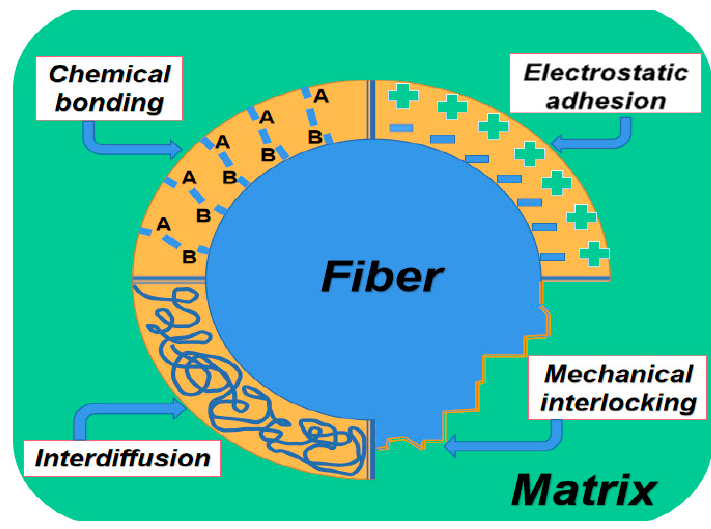
Figure 2. Form of interfacial adhesion between fiber and matrix.